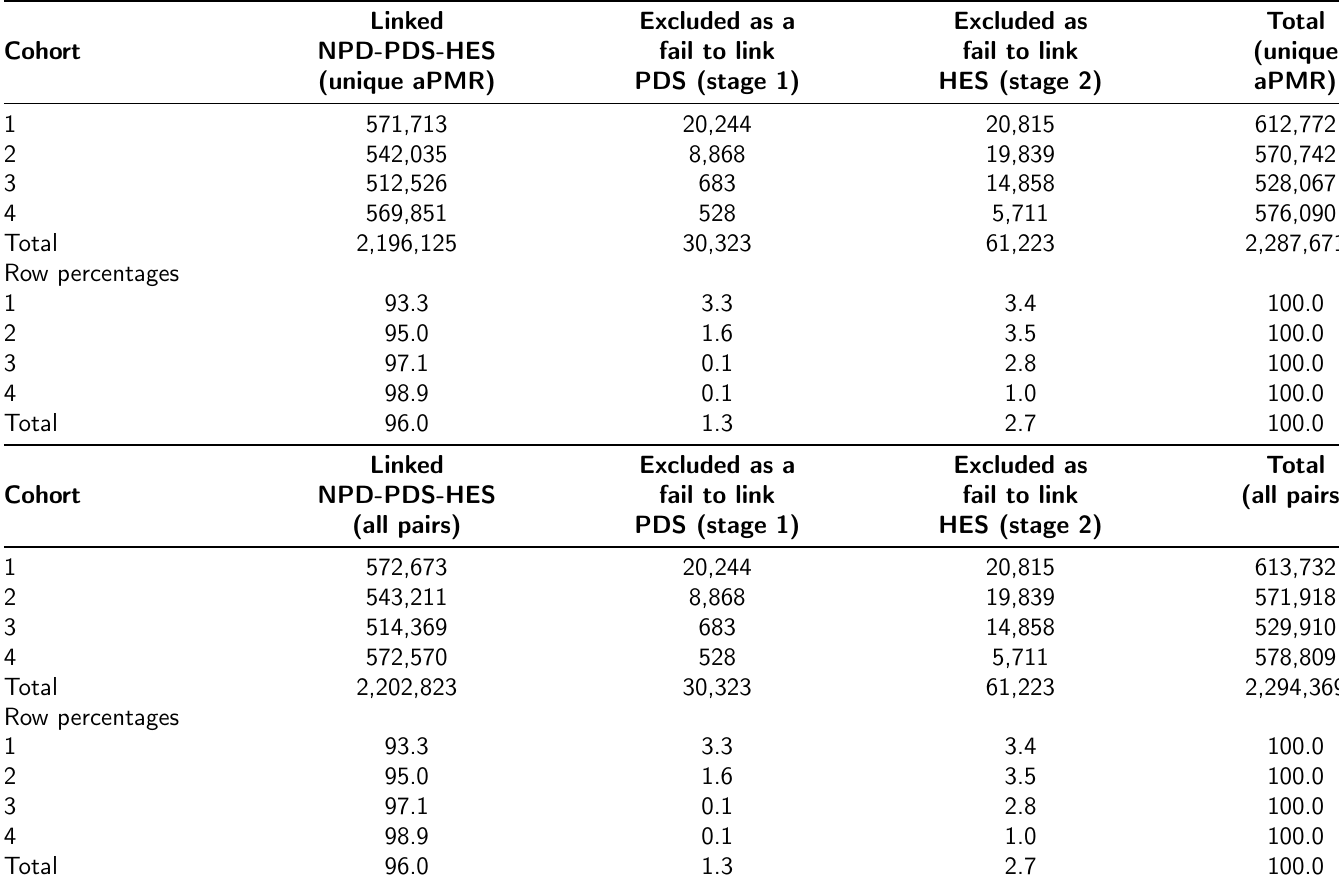
Supplementary Table 5.1: Pupils records by linkage stage (stages 1 and 2) and cohort